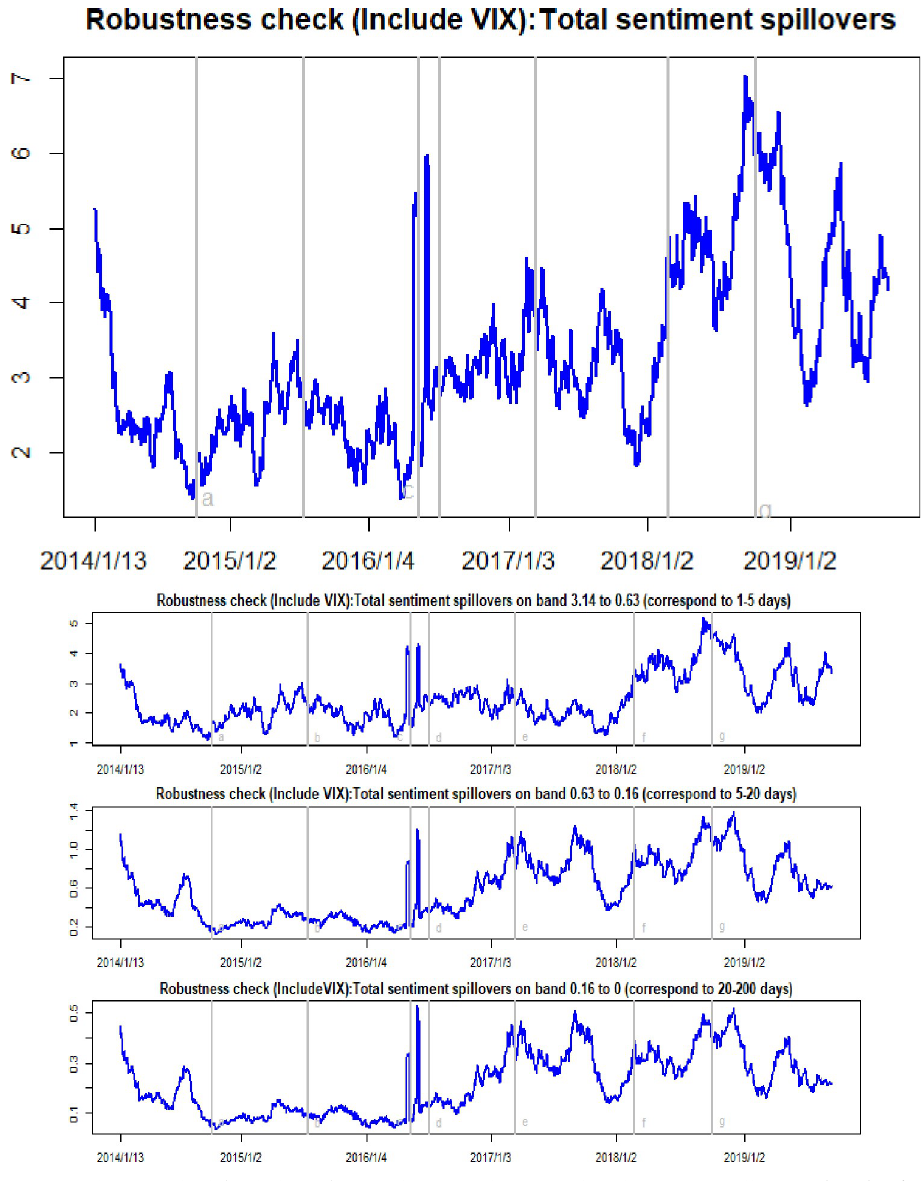
Fig 11. Robustness check (Include VIX): Time-frequency dynamics of total sentiment spillovers. a, b, c, d, e, f, g respectively represent the seven events: the WTI oil price collapsed in October 2014, the black swan event in gold market occurred in July 2015, the sharp rise of Bitcoin prices in May 2016, the Brexit event in July 2016, the expectations of a Federal Reserve rate hike in March 2017, the price of Bitcoin and gold fluctuating fall at the beginning of 2018, and the WTI oil price declines in August